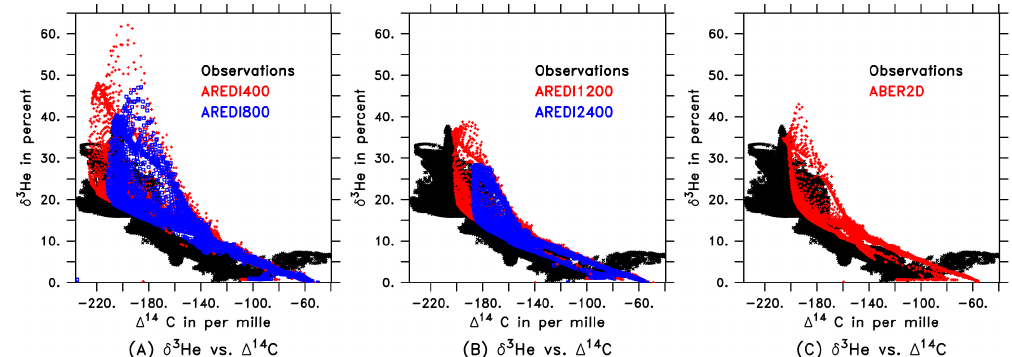
Figure 7. Scatterplots of δ 3 He vs. (cid:49) 14 C for different values of A Redi . On all plots observations are in black. (a) AREDI400 (red) and AREDI800 (blue). (b) AREDI1200 (red) and AREDI2400 (blue) (c) ABER2D (red).